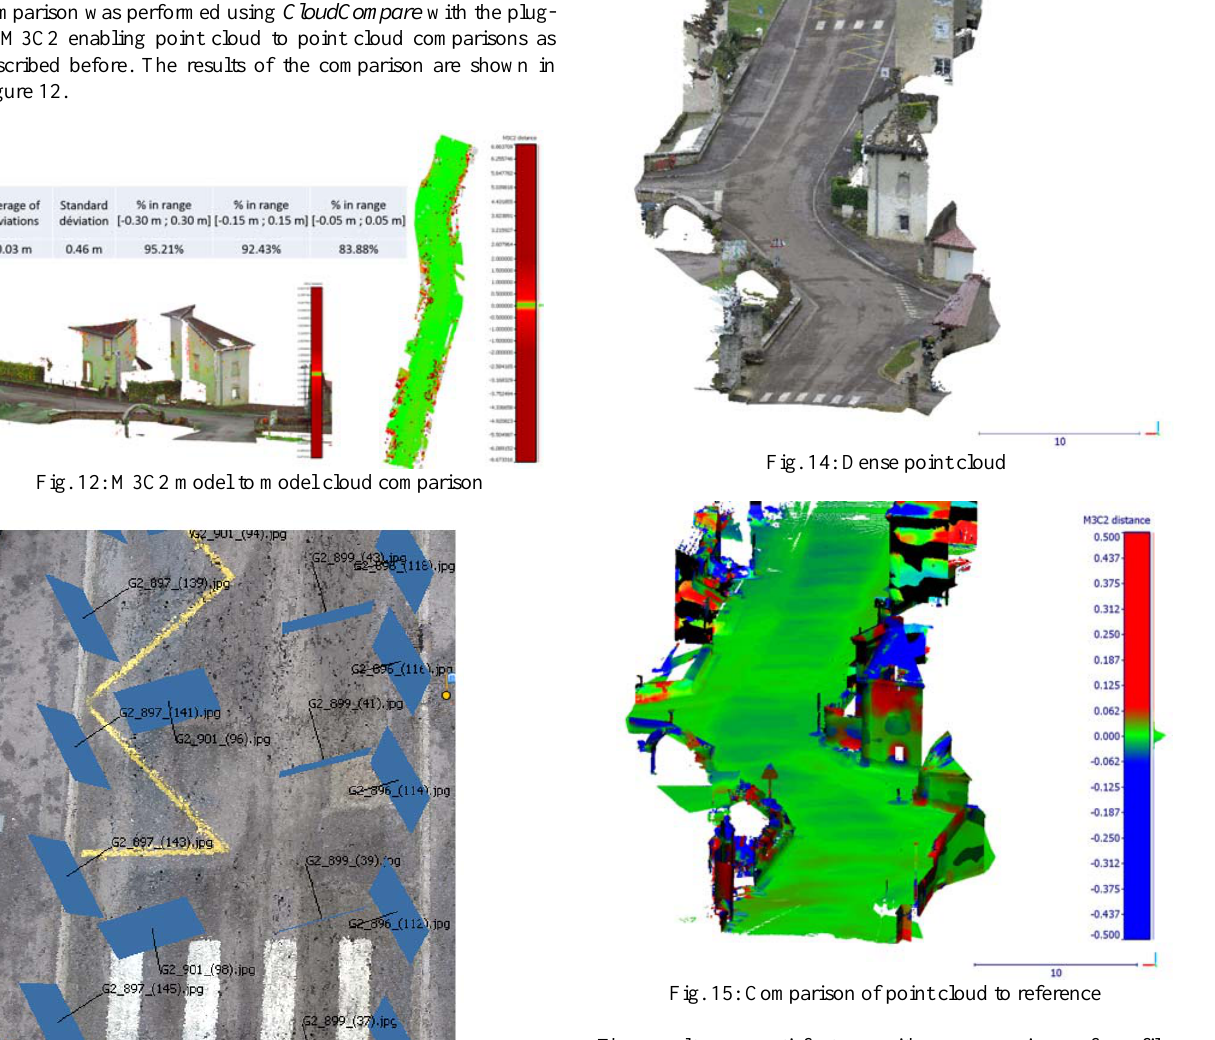
Fig. 13: Image positions in the scene